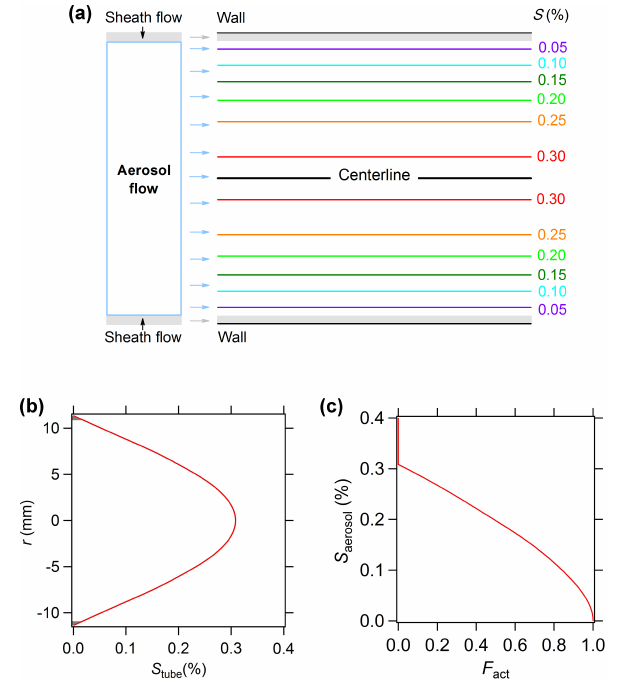
Figure 2. Schematics of BS2-CCN measurements. (a) Contour of supersaturation in the CCN activation unit and configuration of aerosol and sheath flow; (b) distribution of supersaturation in the activation unit ( S tube ) . r is the radial distance to the centerline. The shaded areas represent the sheath flow part, and the non-shaded ar- eas represent the aerosol flow part. The S tube profile is adopted from http://nenes.eas.gatech.edu/Experiments/CFSTGC.html. (c) Plot of the activation supersaturation of aerosol particles S aerosol against the activation fraction F act